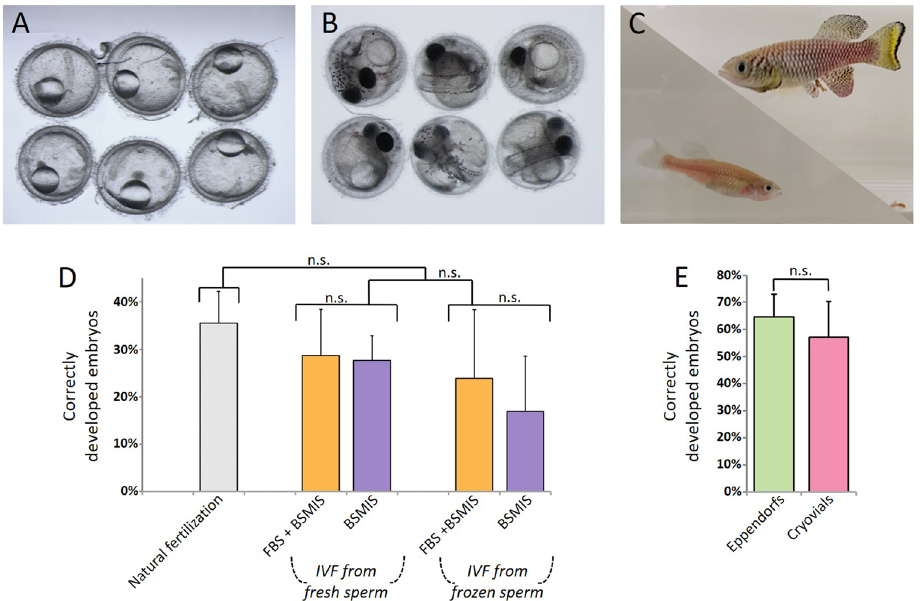
Figure 6. Fertilization rates and embryonic development. ( A ) Embryos fertilized with IVF using frozen sperm develop through diapause II/mid-somitogenesis stage and later ( B ), up to advanced developmental stage. ( C ) Adult fish derived from IVF embryos. ( D ) Fertilization efficiencies of natural breeding, IVF with fresh extracted sperm, and IVF with sperm frozen for 2 weeks. ANOVA post hoc Tukey’s test. N = 6, 8, 4, 10, 3 independent fertilization trials for each fertilization condition, respectively, in order of appearance in the graph. N = 1023, 440, 349, 485, 201 total eggs used for fertilization in the trials for each fertilization condition, respectively, in order of appearance in the graph. ( E ) Fertilization efficiencies of IVF using sperm frozen for 50 days in Cryovials or Eppendorf tubes. The egg pool used for fertilization derived from 10 weeks old females. Three independent trials were performed using different females and sperm aliquots. N = 45 total eggs used for cryovials (fertilized with 3 different sperm aliquots) and N = 52 total eggs for Eppendorfs (fertilized with 3 different sperm aliquots) tests. t test between the two groups results was not